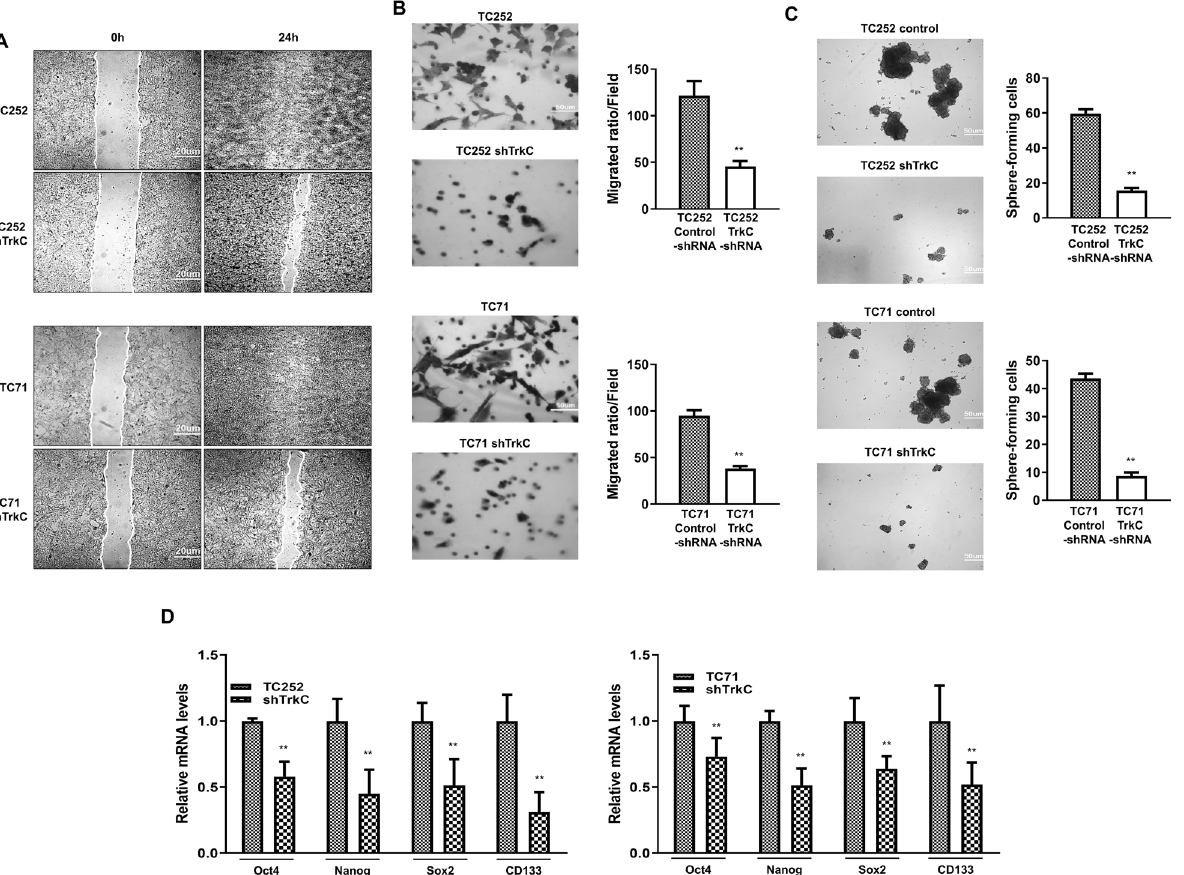
Fig. 2 TrkC is essential for the induction of metastatic ability of ES cells. A Wound-healing assay of TC252 and TC71 control-shRNA and TrkC-shRNA cells. Wound closures were photographed at 0 and 24 h after wound generation. n = 3. B The migration assay of TC252 and TC71 control-shRNA and TrkC-shRNA cells. Migrated cells were photographed after analysis. P values < 0.05 (**); t test. n = 3. C Sphere formation assay of TC252 and TC71 control-shRNA and TrkC-shRNA cells. Sphere formations were photographed. n = 3. P values < 0.05 (**); t test. D Quantitative RT-PCR analysis of Oct4, Nanog, Sox2, and CD133 expression in TC252 and TC71 control-shRNA and TrkC-shRNA cells. The 18S was used for loading control. n = 3. P values < 0.05 (**); t